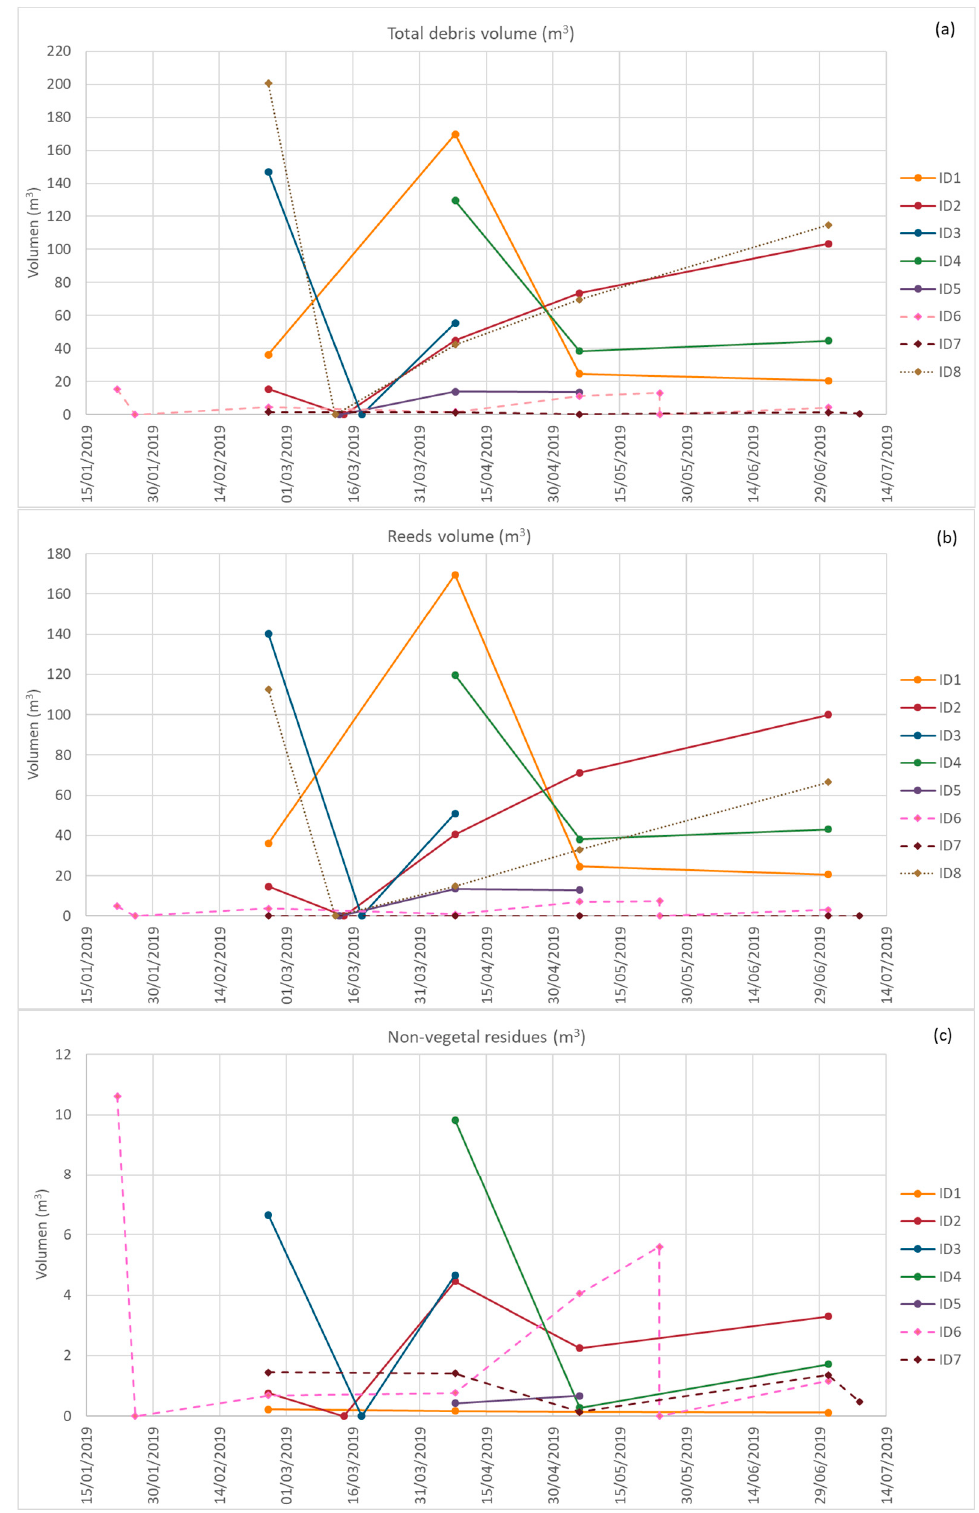
Figure 5. Estimated volume of debris at sampling points on the riverbank ( continuous lines ), channels ( dashed lines ) and floating screen ( dotted line ): total debris volume ( a ), volume of reeds at sampling points on the riverbank ( b ), non-vegetal residues on the riverbank and channels ( c ). The trend in ID1 is quite different from the rest of measuring points. ID1 is a shallow weir that is able to retain the floating waste when the river water levels are low but not when water levels rise. The sharp increase of debris volume between 30 March and 15